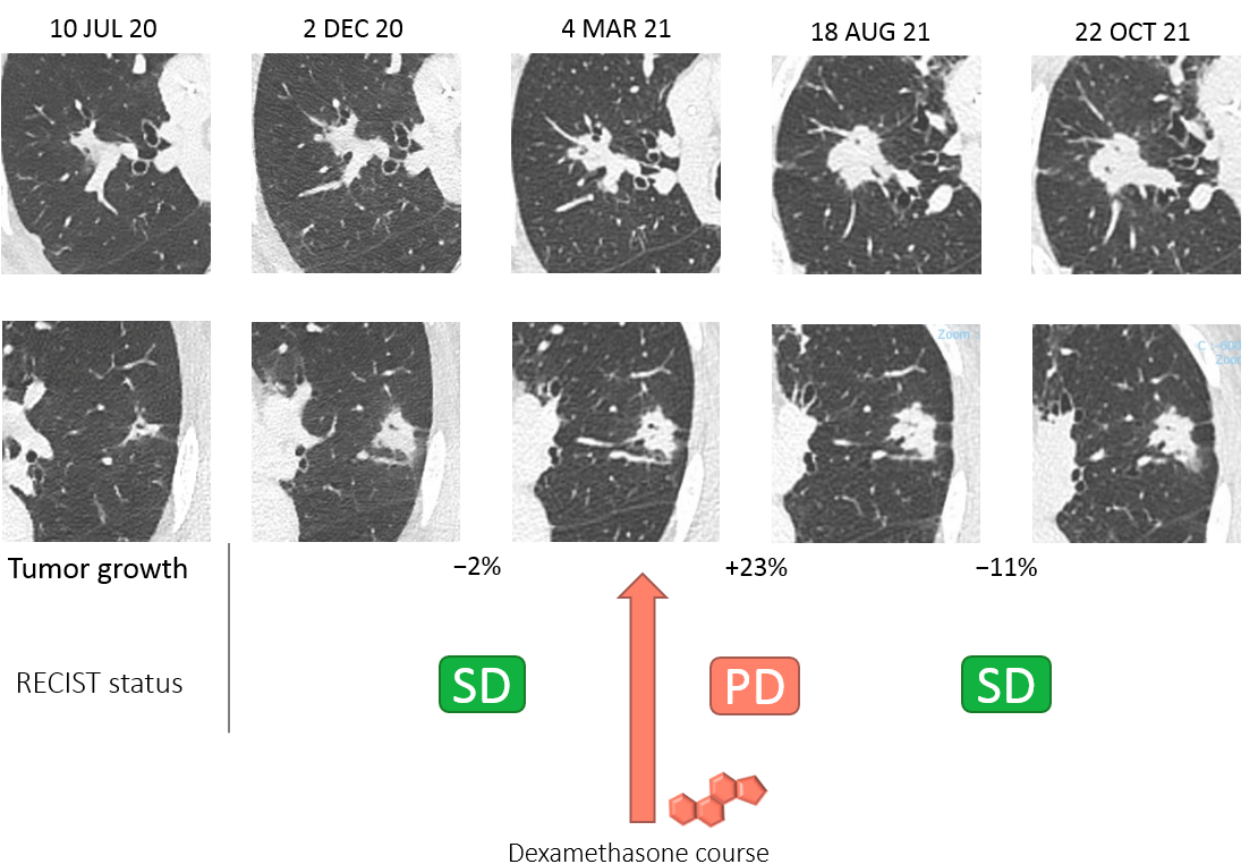
Figure 2. Timeline of TDM scan evaluation of the two target lesions according to RECIST 1.1 criteria.